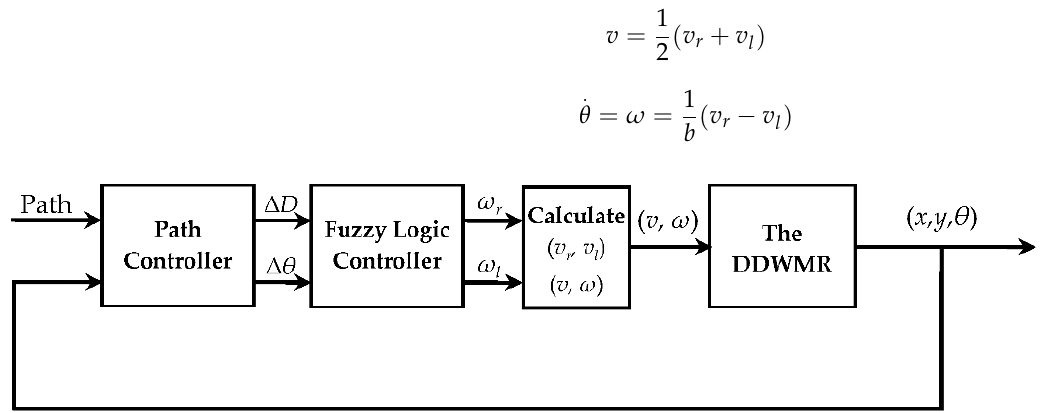
Figure 6. The block diagram of the fuzzy logic controller used for the differential drive wheeled mobile robot.